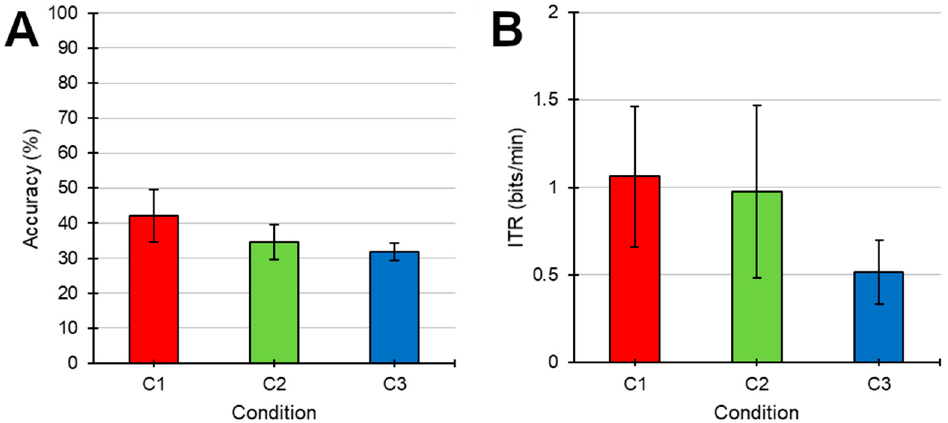
Figure 4. (A) Accuracy (%; mean ± standard error) and ( B )ITR (bits/min; mean ± standard error) of each condition (C1, no speech; C2, ignoring the speech; C3, listening to the speech) during the online phase.